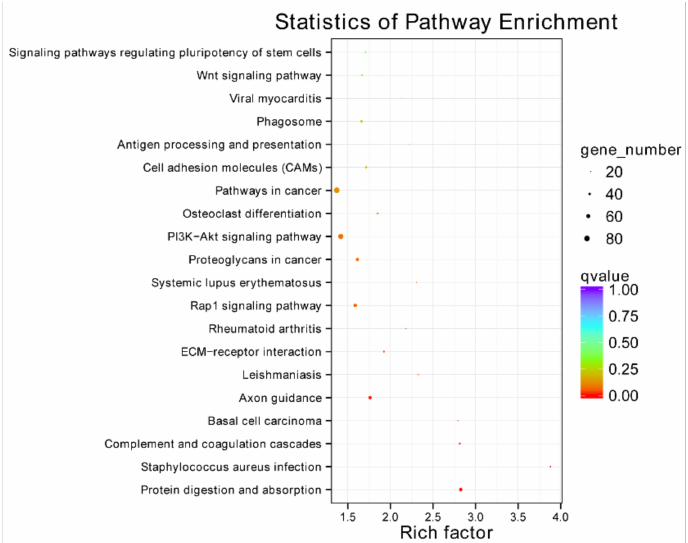
Figure 5. KEGG classification of all DEGs. For KEGG annotation, each circle represents a pathway, the ordinate indicates the name of the pathway, and the abscissa is the enrichment factor. The color of the circle represents the q value, which is the p value after multiple hypothesis test correction. The circle size indicates the number of target genes enriched in the pathway. Pathways with redder colors and larger circles had greater reference values. Twenty pathways with minimum q values are displayed in this